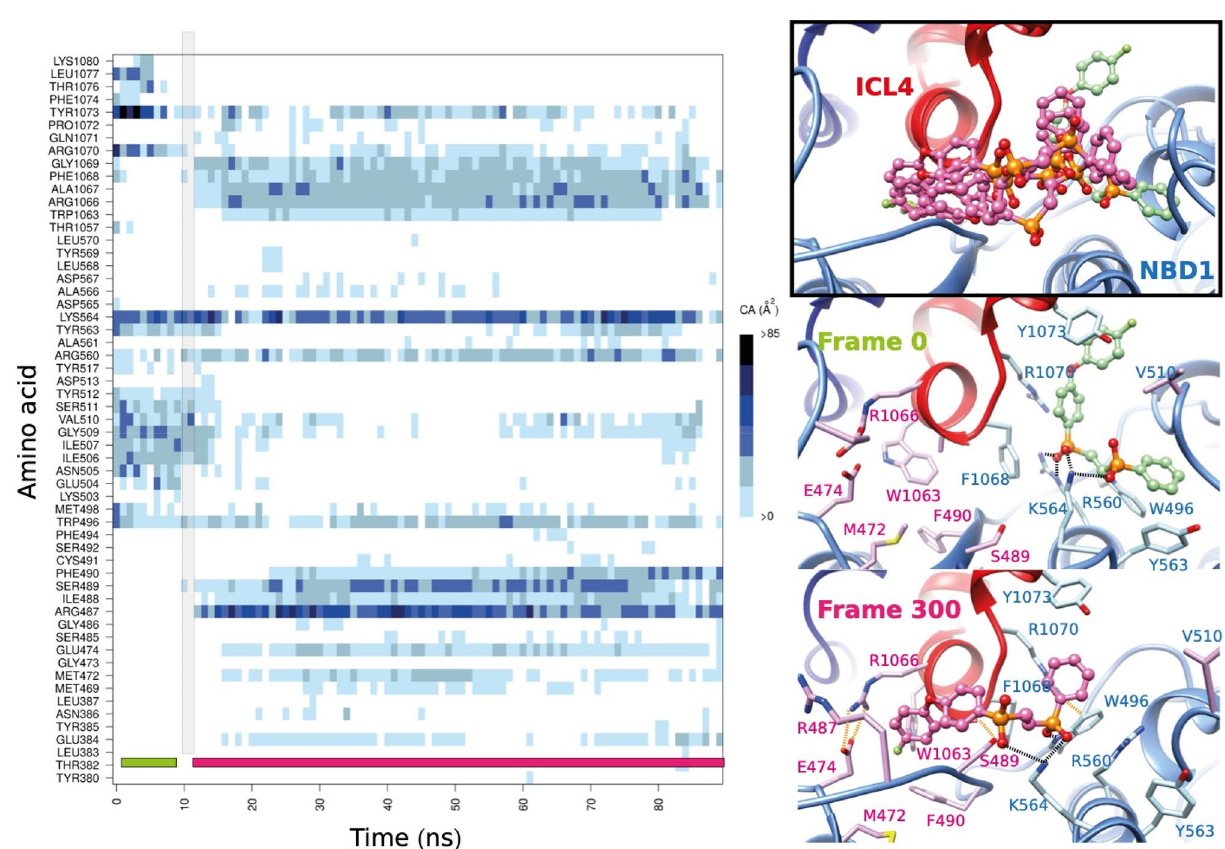
Figure 5. Molecular dynamics simulation of the F508del MSDs:NBDs assembly in complex with the extended c407 analog, G1. The contact map is shown on the left-hand side, with highlighted in grey, the transition area between two different positions. On the right-hand side are shown positions of G1 along the MD simulations (top), taken each 100 ns and highlighting the initial position (in green) and the position stably adopted after less then 10 ns MD simulation (pink). The middle and bottom panel illustrate the position and contacts of G1 before (Frame 0) and after 60 ns (Frame 300) MD